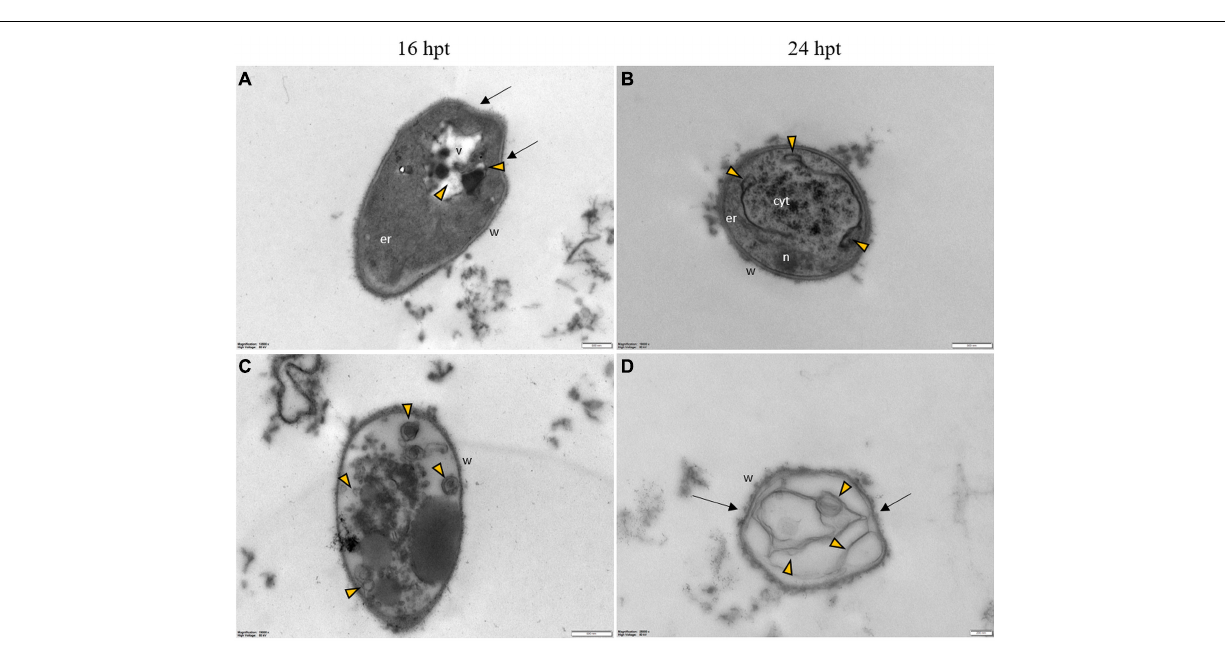
FIGURE 11 | Representative TEM micrographs of Pyricularia oryzae hyphae treated with Pep 4Rink 50 µ M and observed at 16 (A,C) or 24 hpt (B,D) . Hyphae exhibit significant ultrastructural changes, similar to what described in samples treated with Pep 4Rink 25 µ M, such as distortion of the cell wall ( A,D , arrows) and abnormal vacuolation ( A-D , yellow